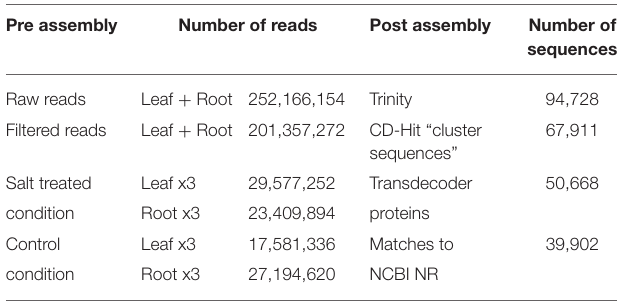
TABLE 1 | Summary of assembly, from sequencing reads produced to final unigenes